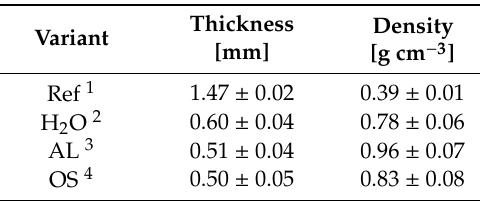
Table 3. Comparison of thickness and density of native, densified and densified chemically treated spruce veneers. ( n = 5 for Ref; n = 5 for H 2 O; n = 5 for AL; n = 5 for OS).